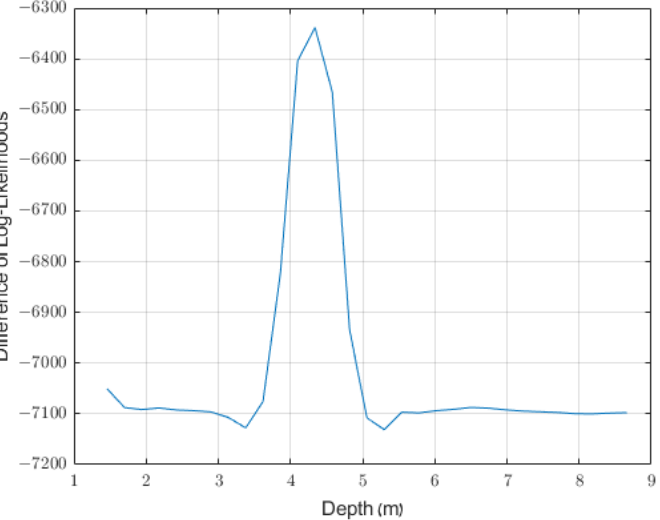
Figure 9. The results of applying our method to the simulated profile shown in Figure 8. We examined the frequency range of 16–80 MHz, used a window size of four depths (one meter), and used a guard distance of two depths (0.5 m). The cavity was assumed to have a width of one